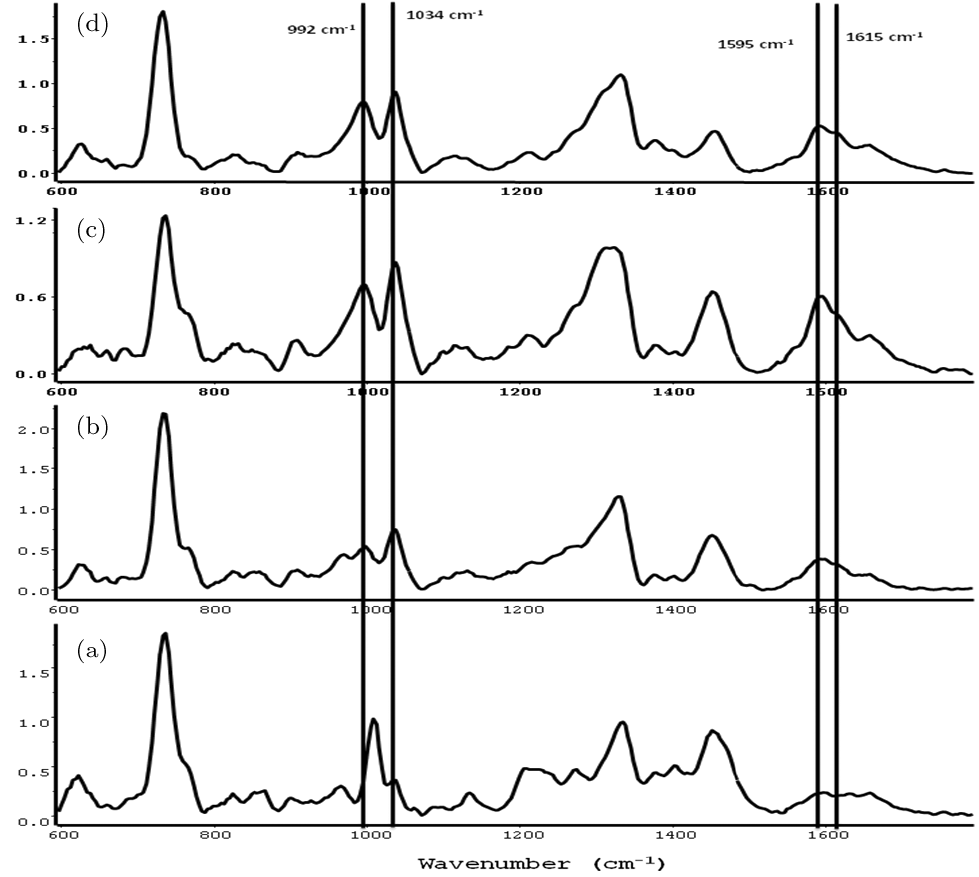
Fig. 6. Representative spectra for SERS approach in drug-spiked plasma. SERS approach to achieve therapeutically relevant concentrations was then investigated in drug-spiked plasma. Concentrations ranging from 0.1 – 0.001 mg/mL were spiked in plasma and deposited on suitable nanoparticle substrates. Imatinib-speci¯c signals could also be detected in the lowest concentration. (a) Blank plasma, (b) Lowest concentration: 0.001 mg/mL (1 (cid:1) g/mL), (c) Concentration: 0.005 mg/mL, (d) Highest concentration: